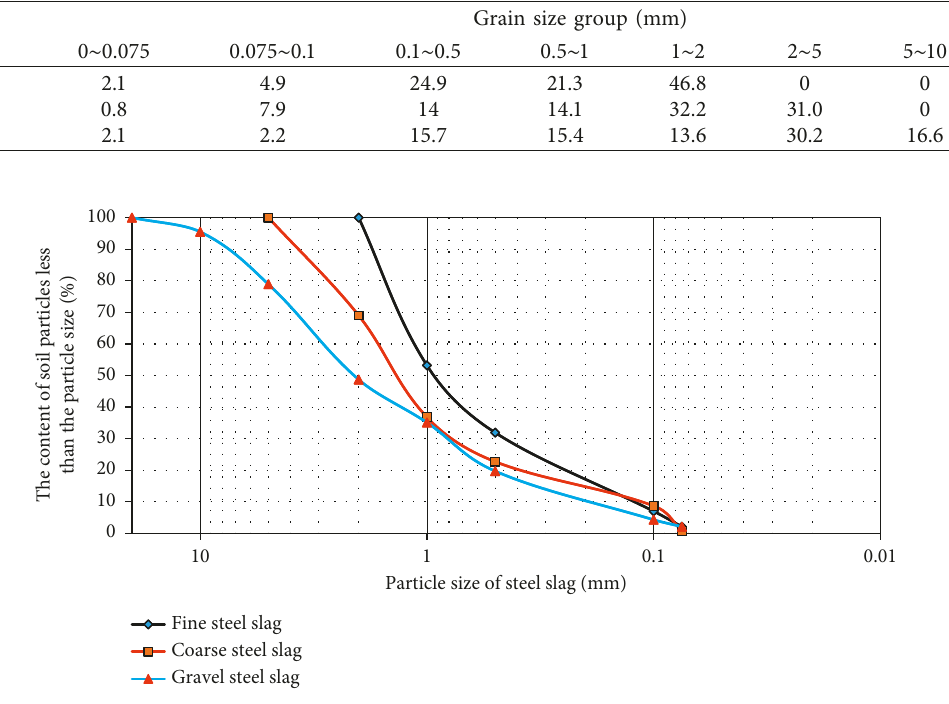
Figure 2: Grading curves of three kinds of steel slag.